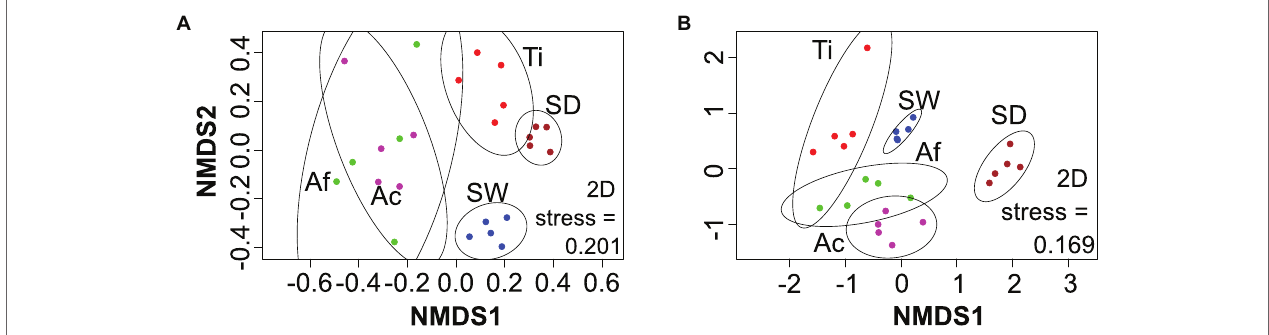
FIGURE 4 | nMDS based on Bray–Curtis distances for the fungi (A) and unicellular eukaryotic (B) datasets. Ac, Aplysina caissara ; Af, Aplysina fulva ; Ti, Tedania ignis ; SW, seawater; and SD,